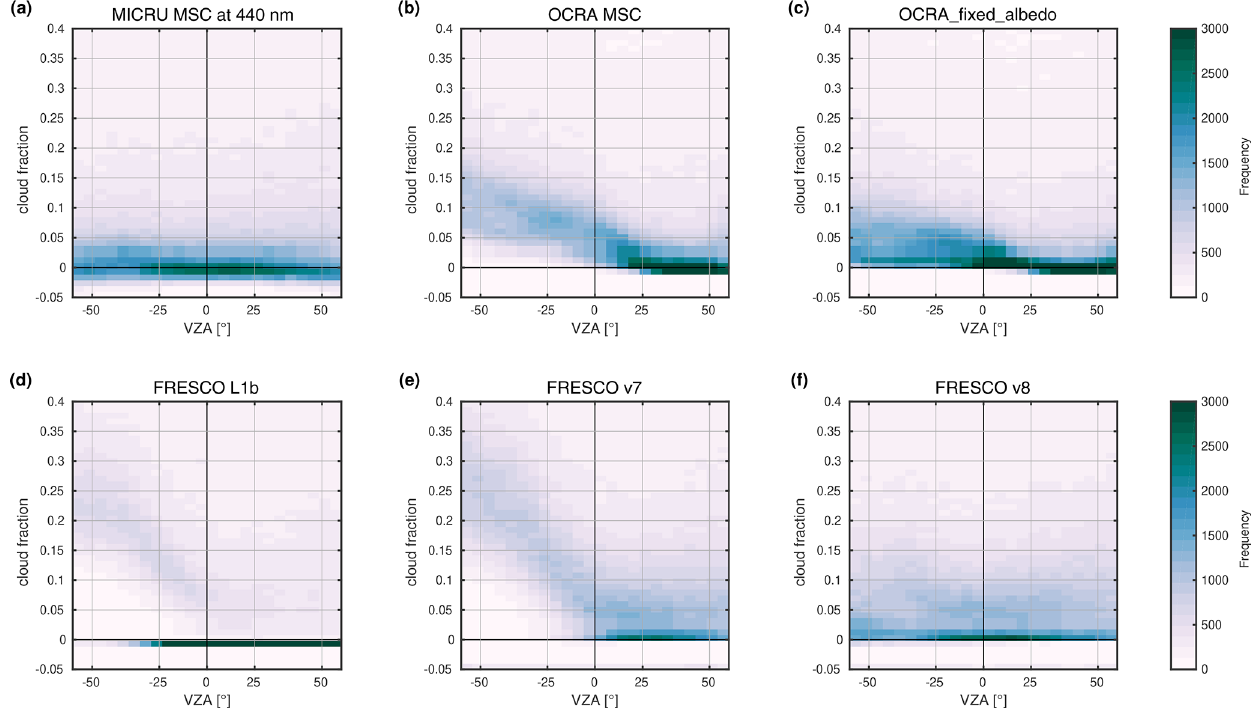
Figure 11. Comparison of viewing angle dependence of small CFs over land between the 55 ◦ parallels: (a) MICRU MSC at 440nm, (b) OCRA MSC, (c) OCRA_fixed_albedo, (d) FRESCO L1b, (e) FRESCO v7, and (f) FRESCO v8. Statistics are based on April 2010 data.